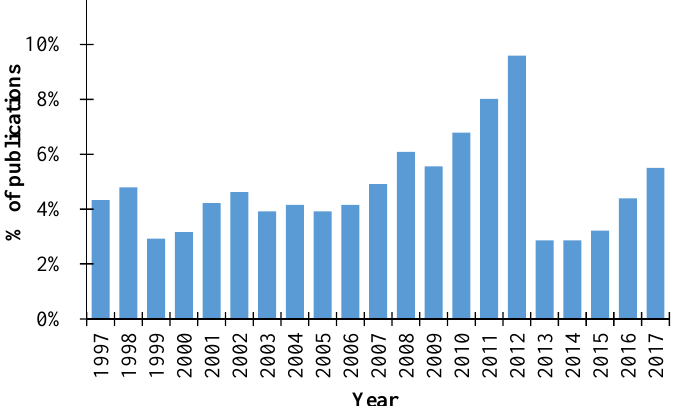
Figure 3. Percentage of publications searched by the Web of Science that were related to the recycling of PUs.